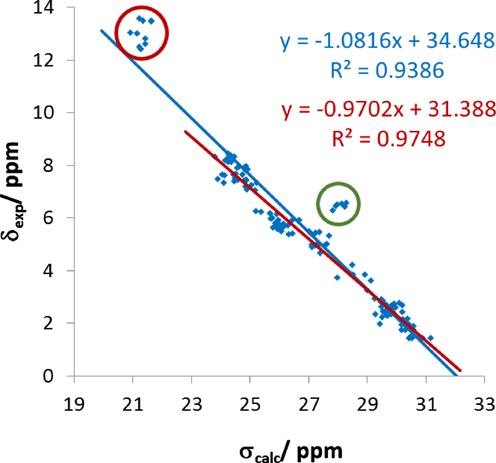
Correlations of the calculated isotropic chemical shielding with the experimental chemical shifts for a DNA duplex containing the potent anti-poxvirus agent cidofovir (PDB entry 2L8P, BMRB entry 17422): Correlation lines based on all nuclei (blue line) and neglecting the two problematic groups (red line, neglected nuclei in red and green circles) are shown.